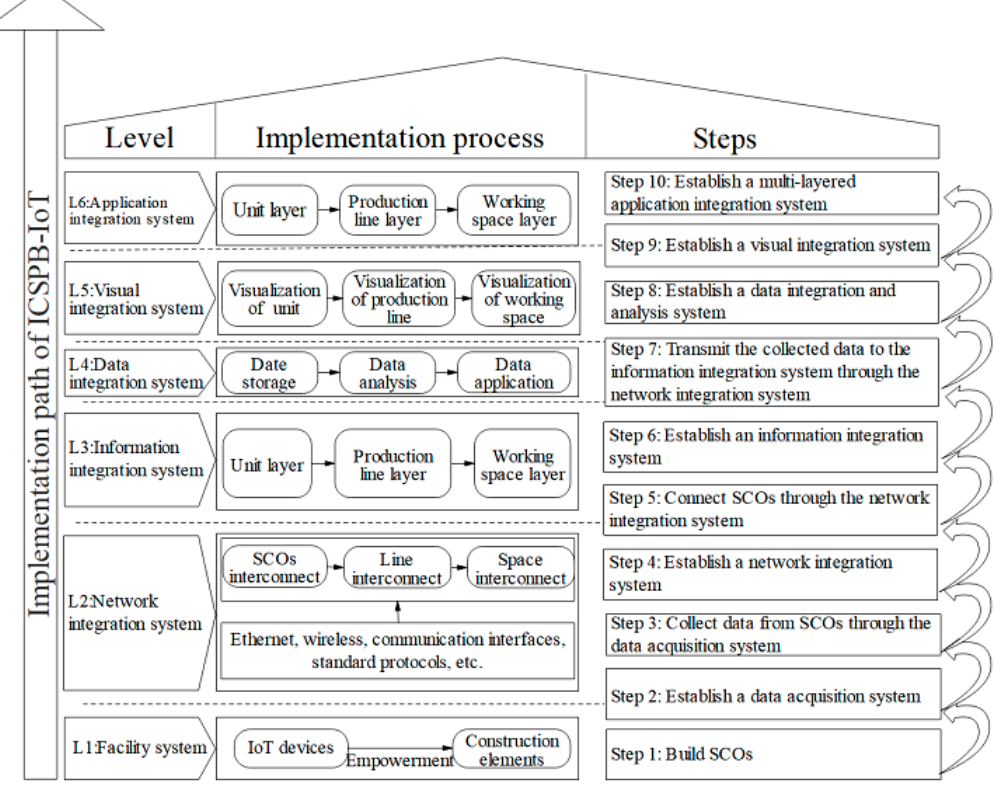
Figure 6. The implementation path of ICSPB-IoT.